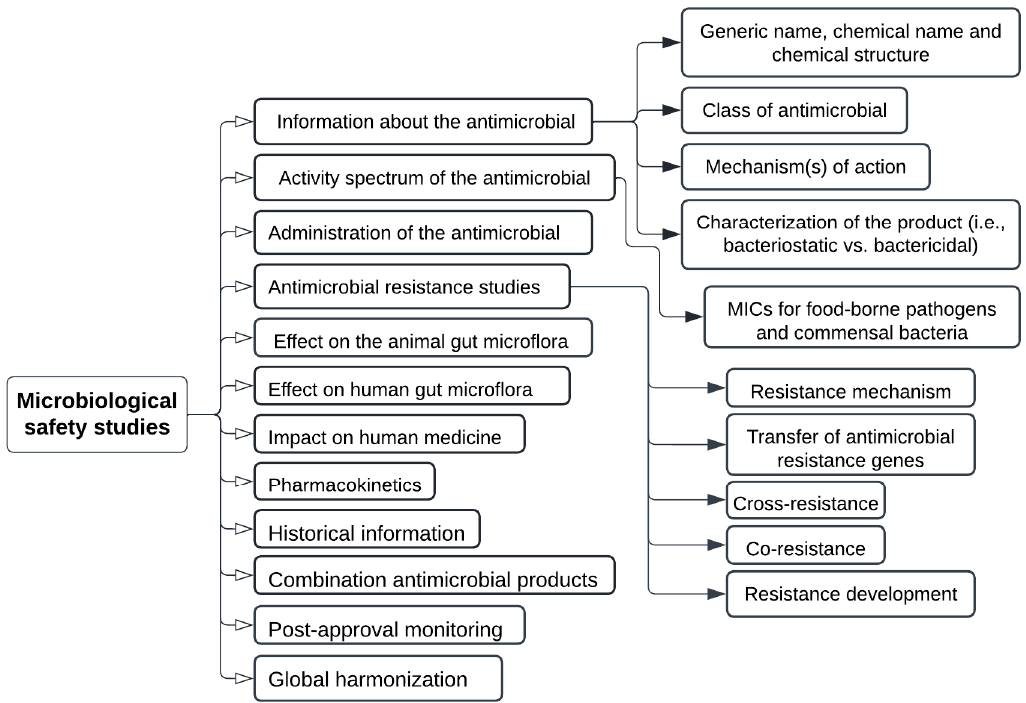
Figure 5. Microbiological safety assessment for alternatives to antibiotic growth promoters as per regulation approval, where cross resistance, co-resistance, resistance gene transfer, and resistance development mechanism are categorized as antimicrobial resistance studies.